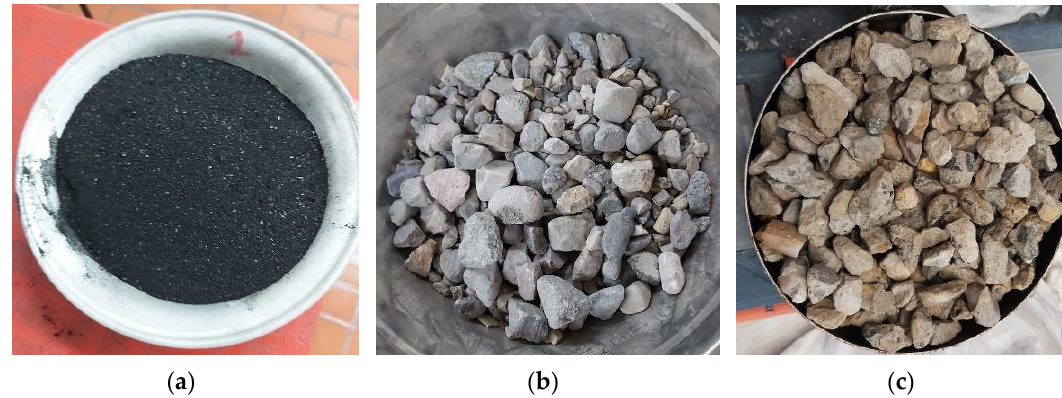
Figure 1. Materials: ( a ) gilsonite (G); ( b ) natural origin aggregates (NA); ( c ) recycled concrete aggregate (RCA). Table 2. Properties of NA and RCA particles.